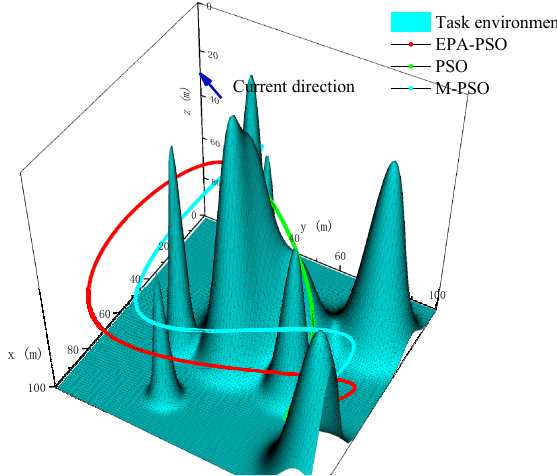
Figure 24. 3D path planning after 500 iterations.